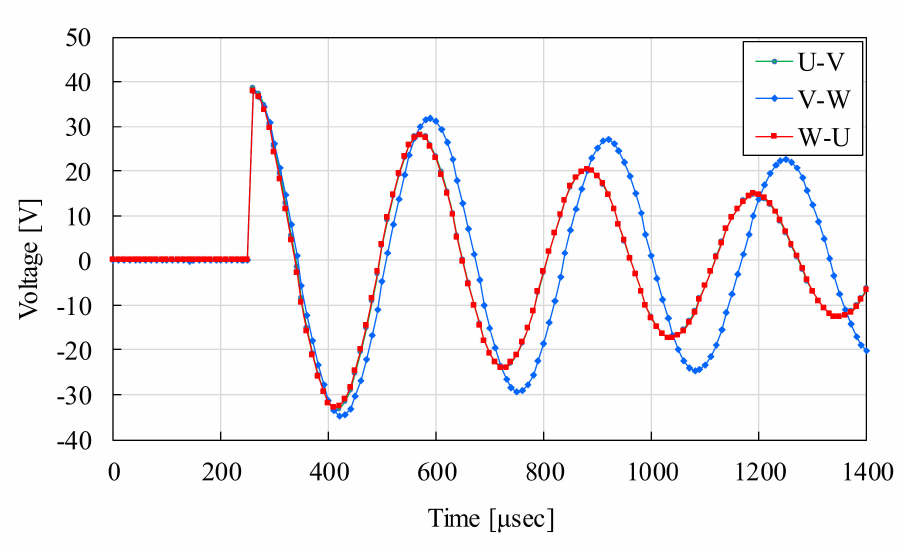
Figure 6. Waveform of a two-turn SCF.